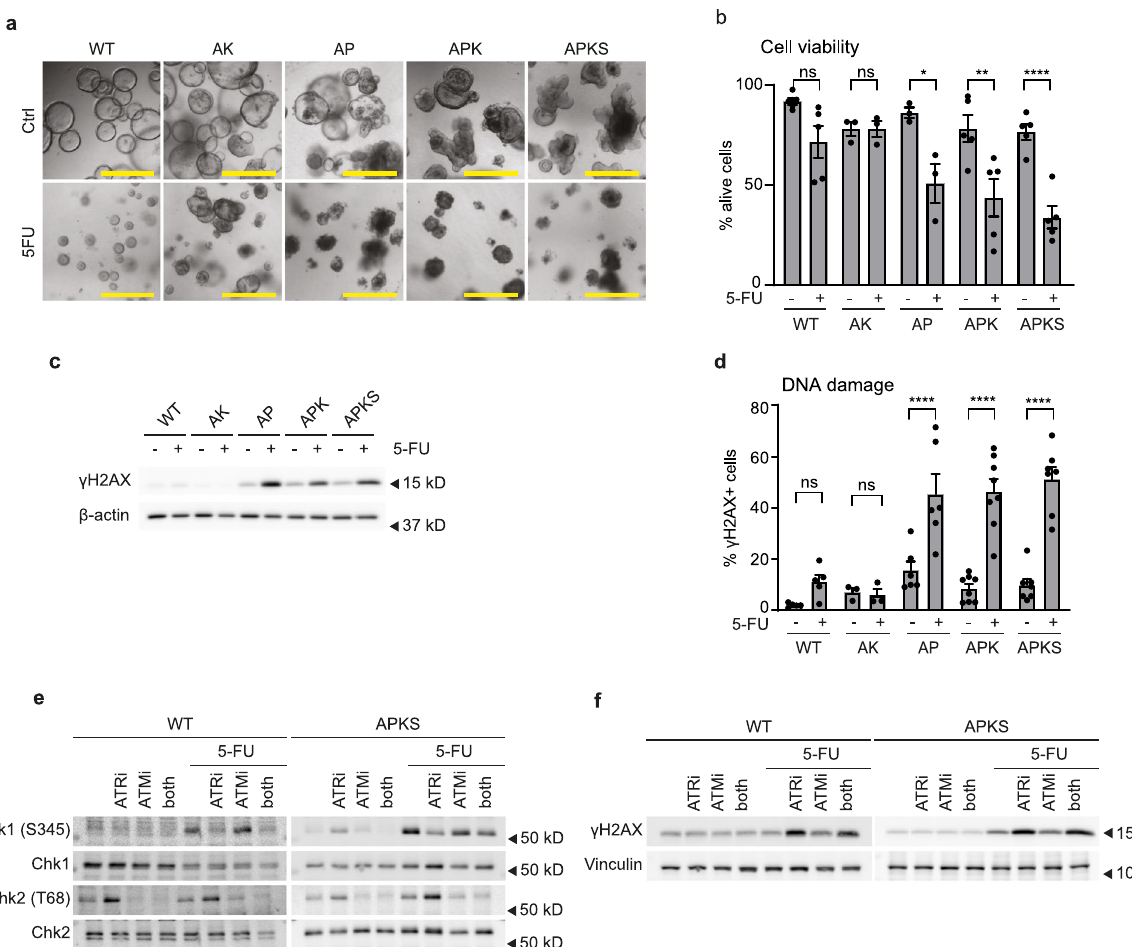
Fig. 1 5-FU induces DNA damage and cell death in p53-de fi cient CRC organoids. a Representative bright fi eld images of WT and CRC organoids treated with 5-FU for 7 days (scale bar = 500 µ m). b Cell viability analysis of WT and CRC tumor organoids by fl ow cytometry to distinguish alive (DAPI − ) from dead cells (DAPI + ) upon 7 days of 5-FU treatment (mean ± SEM, n = 3 – 5, one-way ANOVA, Sidak ’ s multiple comparisons test). c Western blot detection of γ H2AX and β -actin in lysates from WT and CRC tumor organoids treated with 5-FU for 48 h (representative for n = 5). WT, AK, AP, APK, APKS were run together on the same gel. d Quanti fi cation of cells with DNA damage by fl ow cytometry of WT and CRC organoids treated with 5-FU for 48 h and stained with anti- γ H2AX (mean ± SEM, n = 5 (WT), 3 (AK), 6 (AP), 8 (APK and APKS), one-way ANOVA, Sidak ’ s multiple comparisons test). e , f Western blot detection of (p)Chk1, (p)Chk2, γ H2AX and vinculin of lysates from WT and APKS organoids treated with 5-FU for 24 h and co-treated with either ATR inhibitor VE-821 or ATM inhibitor KU55933 or both for 26 h (representative for n = 3, WT: Chk2: Santa Cruz, #SC-9064, APKS: Chk2: Cell Signaling, #3440). WT and APKS were run on separate gels. ns: non-signi fi cant, * p < 0.05, ** p < 0.01, **** p <